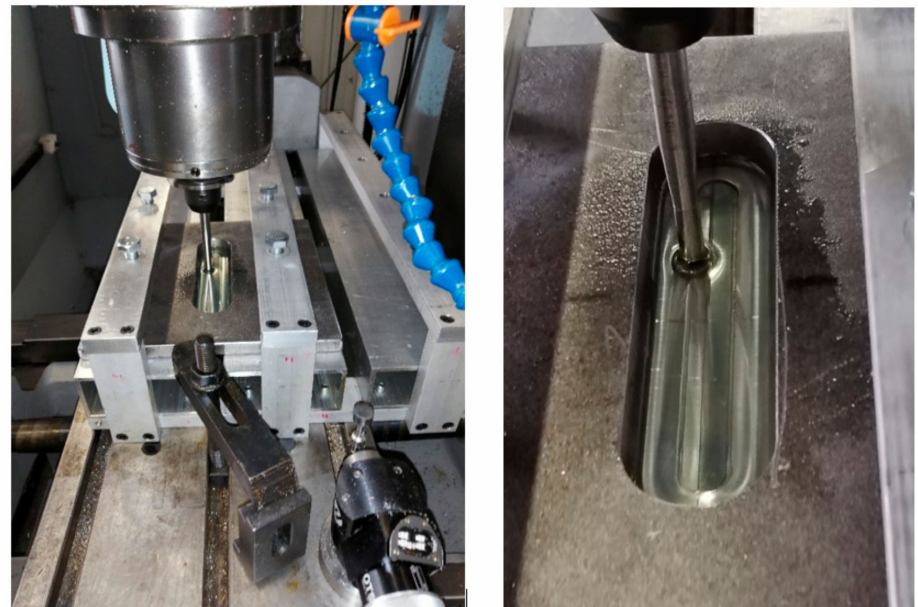
Figure 2. Device for incremental forming mounted in the table of a numerically controlled TM-1P vertical milling